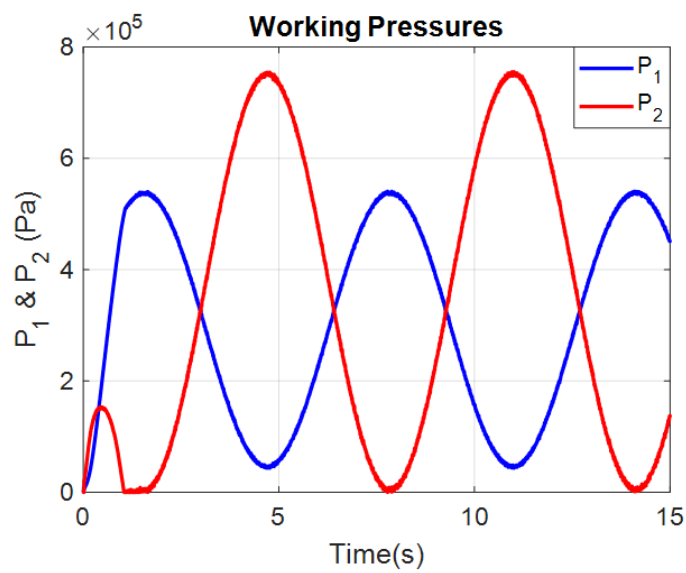
Figure 13. Working pressures of the proposed controller.